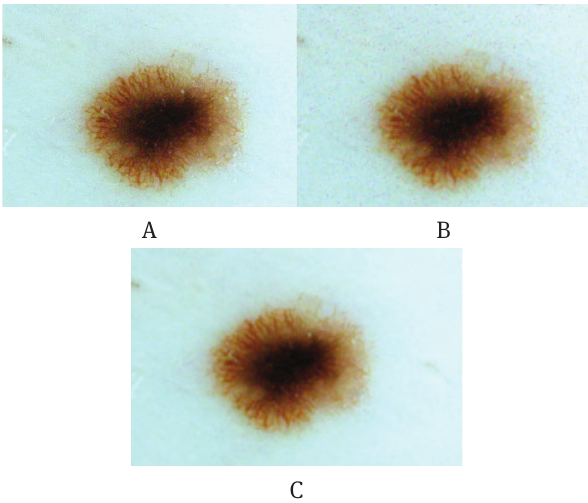
Figure 1: Image noise reduction: (A) input image, (B) apply salt and pepper noise to image and (C) Filtered